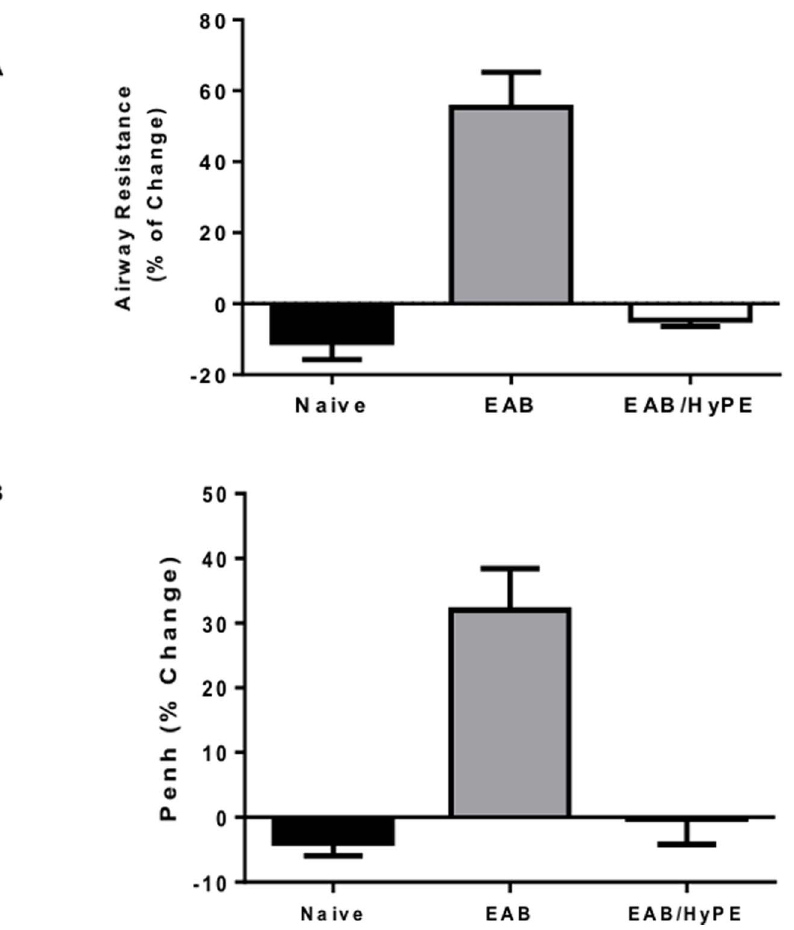
Figure 3. Airway response to challenge in mice with OVA-induced EAB. Mice were subjected to OVA challenge and airway response was determined by airway resistance (3A) and Pulmonary enhancement (Penh, 3B), as described in Methods. In 3A, data are mean 6 SEM for 8 mice, *, # P , 0.05. In 3B, data are mean 6 SEM for 10 mice, *, # , P , 0.01.